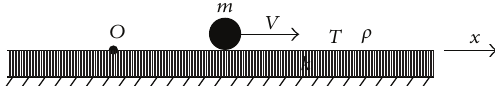
Figure1:ApointmassmovingalongastretchedstringonaWinkler foundation.